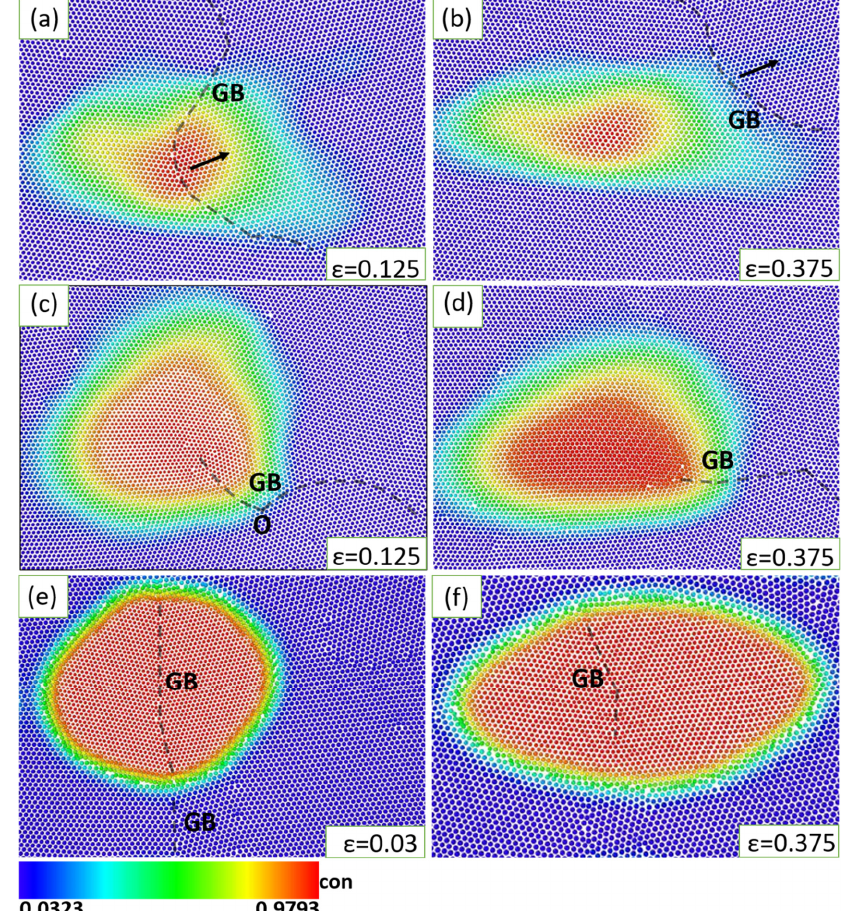
Figure 2. The interactions between GB and precipitate during slow deformation with strain rate 𝜀(cid:4662) = 10 − 4 with lattice misfit ( a , b ) f = 4.3%, ( c , d ) f = 9.2%, ( e , f ) f = 19.3%. Note that the time evolution of deformation process is characterized by the increase of applied deformation strain ( ε ). The black arrows in ( a , b ) are the direction of GB movement. For more details of the three deforming precipitates, please refer to Videos S4–S6 in the Supplementary Materials.